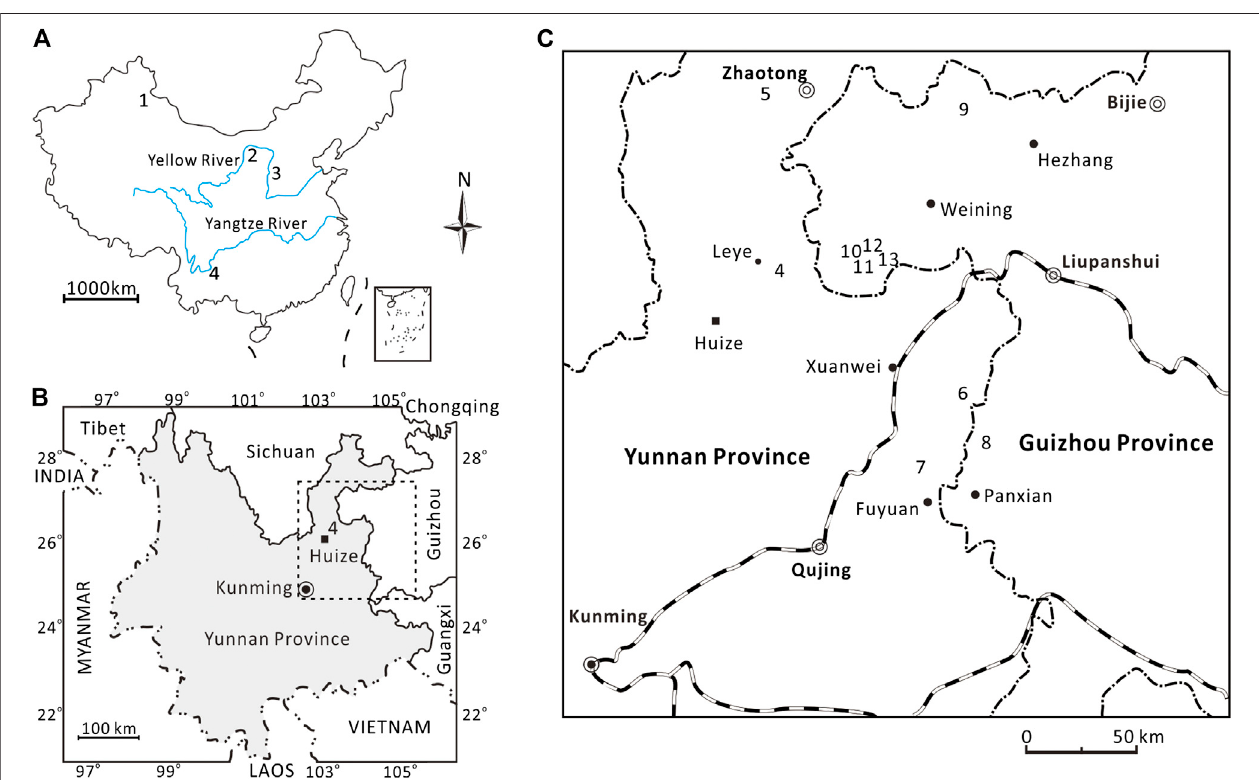
FIGURE 1 | Geographic maps (A – C) showing the Germaropteris martinsii localities in China. 1) Dalongkou (Xinjiang); 2) Baode (Shanxi); 3) Liulin (Shanxi); 4) Lubei (Yunnan); 5) Guanbachong (Yunnan); 6) Mide (Yunnan); 7) Housuo (Yunnan); 8) Tucheng (Guizhou); 9) Lengqinggou (Guizhou); 10) Chahe (Guizhou); 11) Jiucaichong (Guizhou); 12) Xiaohebian (Guizhou); 13) Jinzhong (Guizhou).